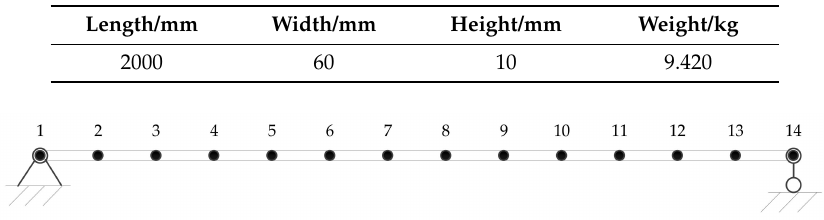
Figure 12. ( a ) Diagrams of experiment system; ( b ) Photo of the experiment system. Table 8. Basic parameters of the simply supported beam.